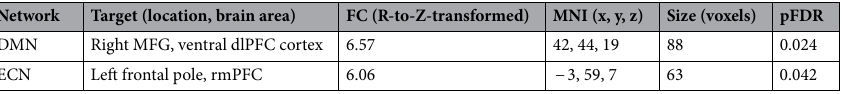
Table 1. Clusters exhibiting a significant association of baseline RSN connectivity with the change in MPQ- VAS scores following real M1-rTMS . DMN , default-mode network, dlPFC dorso-lateral prefrontal cortex, ECN